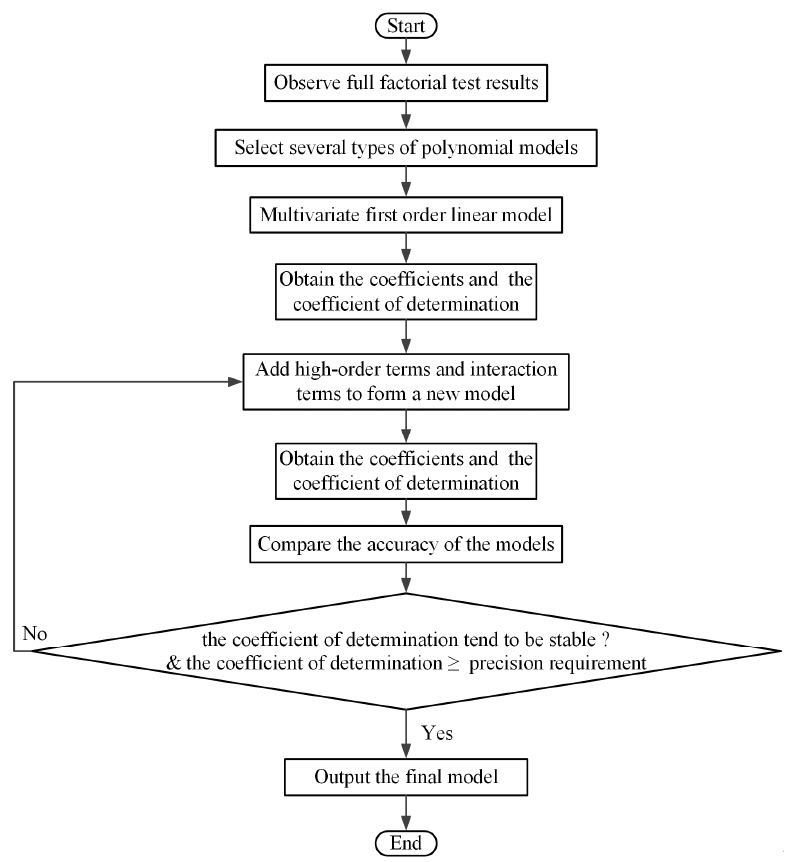
Figure 3. Flow chart of the performance evaluation index modeling method proposed in this paper. The layers of the wet clutch switching quality are shown in Figure 4.